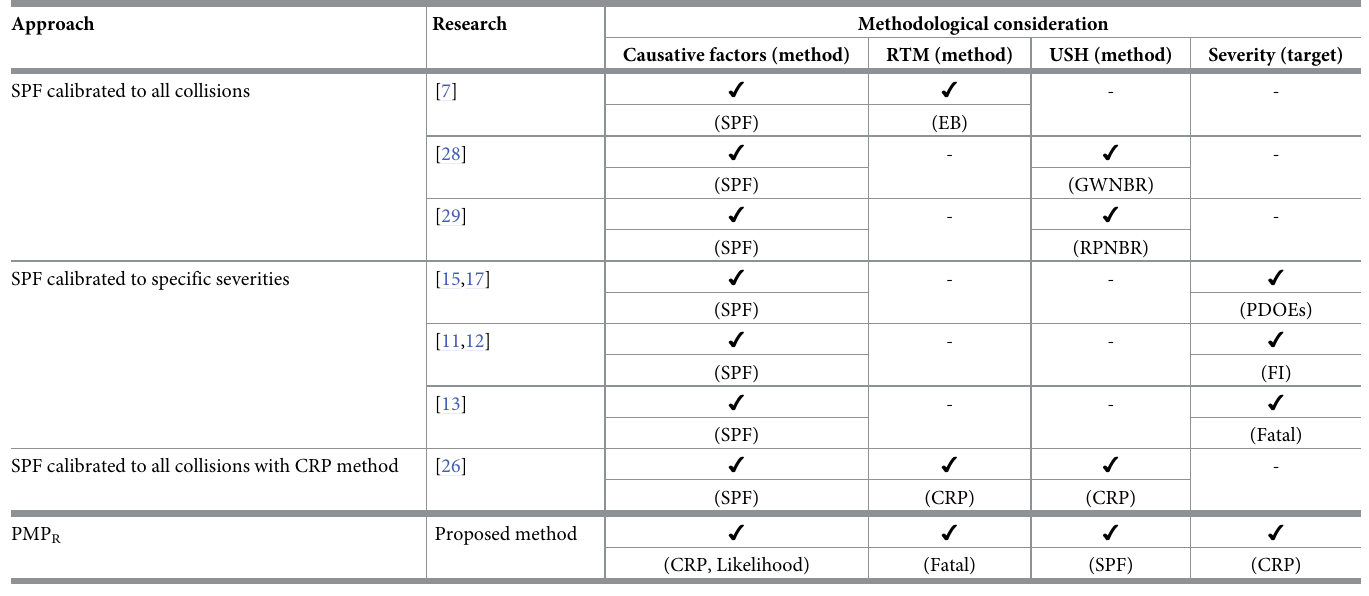
Table 4. Comparison of the methodological considerations of conventional SPF-based approaches and the proposed method. Approach